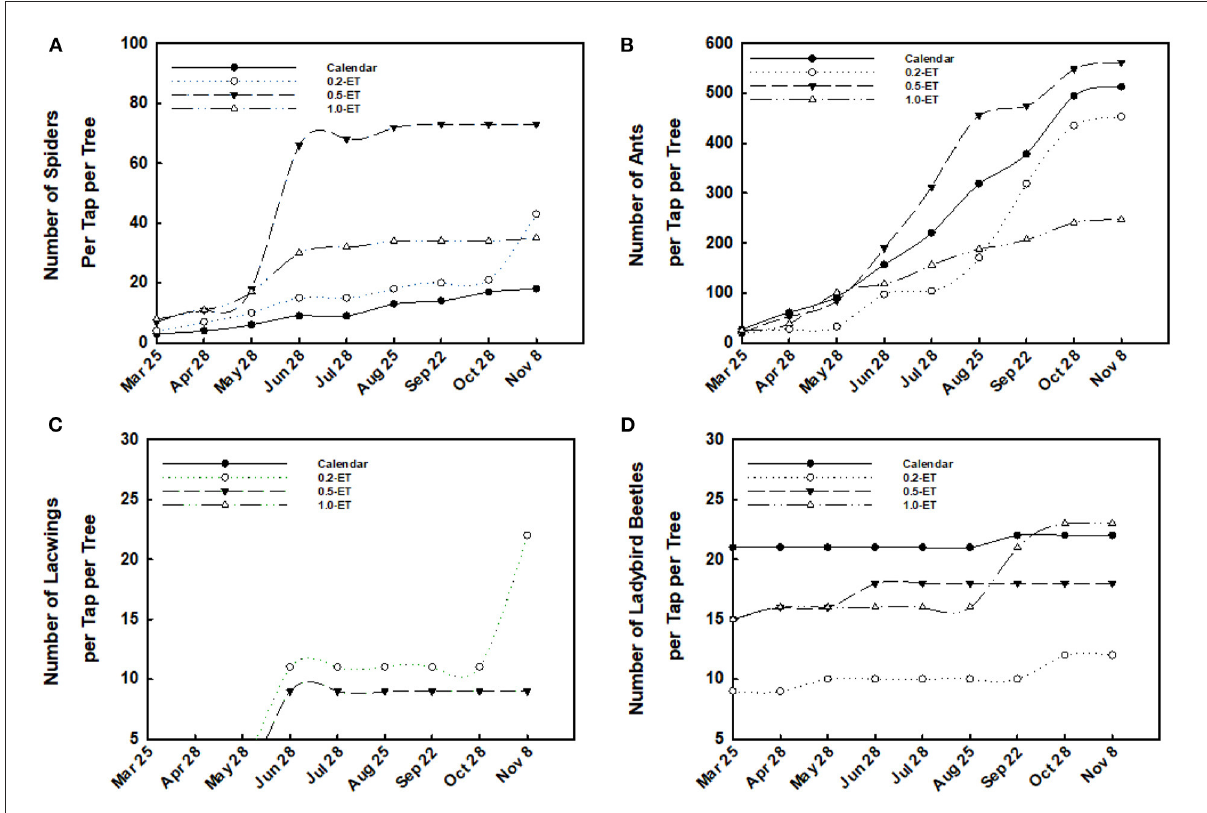
FIGURE2 The cumulative number of natural enemies including spiders (A) , ants (B) , lacewings (C) , and ladybird beetles (D) observed in Florida citrus groves in the different economic threshold (ET) treatments during 2021.